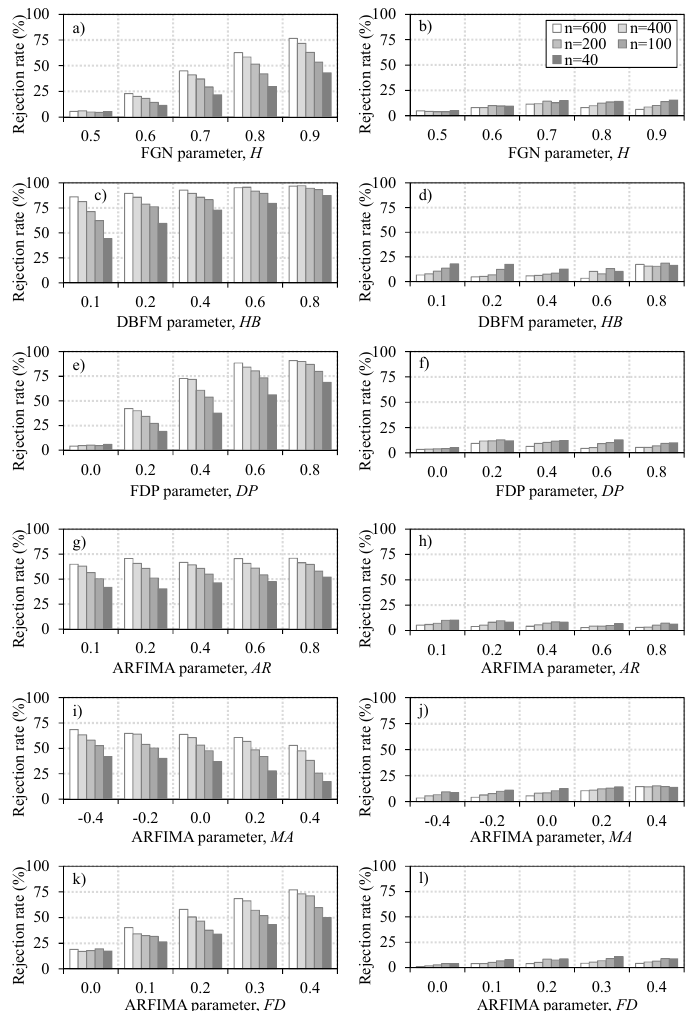
Figure A1. Rejection rate for ( a , b ) FGN; ( c , d ) DFBM; ( e , f ) FDP; and ( g – l ) ARFIMA models. Trend results obtained: ( a , c , e , g , i , k ) without; and ( b , d , f , h , j , l ) with TCSD variance correction for persistence. All the charts share the same legend as in ( b ).